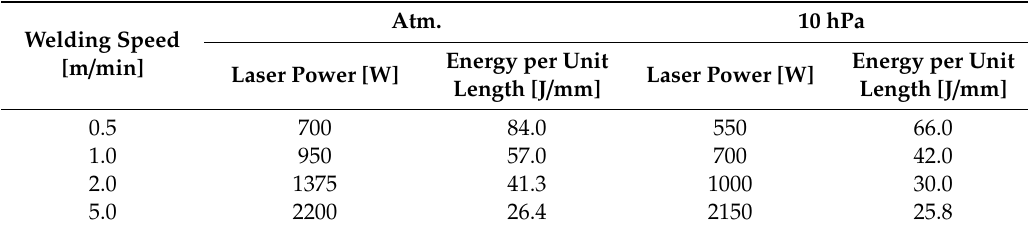
Table 2. Laser welding parameters selected for the investigation of gap bridging ability.